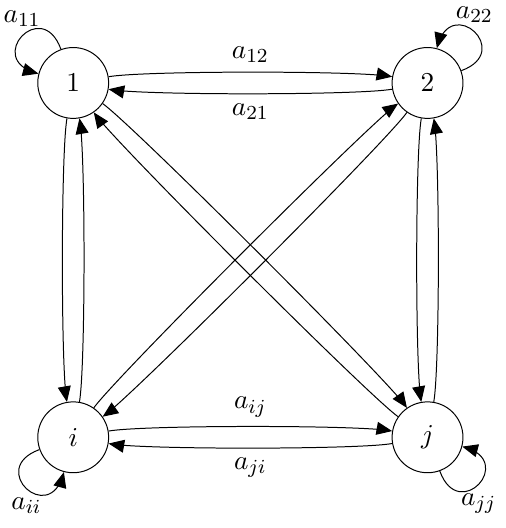
Figure 2: Example of a network of flows between 4